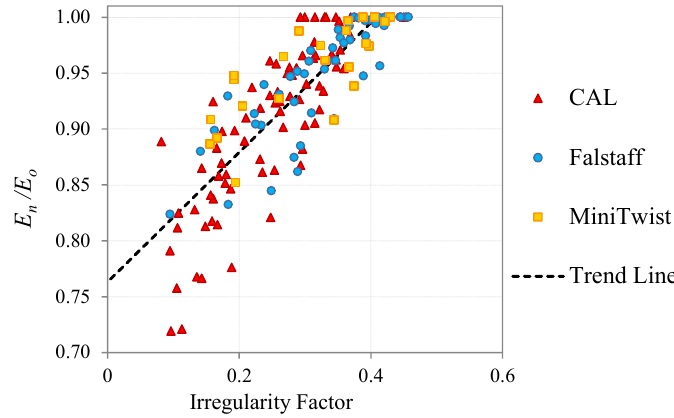
Figure 13. Relation between the stiffness degradation and the I ‐ Factor, for the different type of fatigue loads applied.